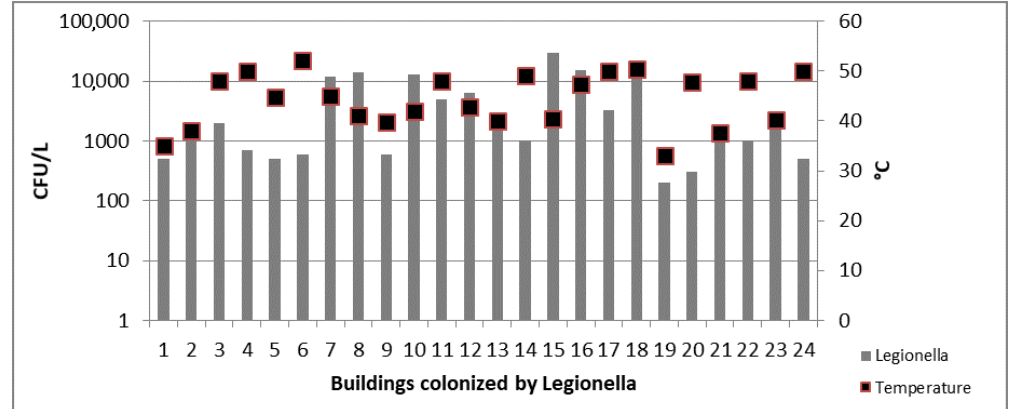
Figure 3. Legionella counts and temperature values detected in 24 colonized CB.